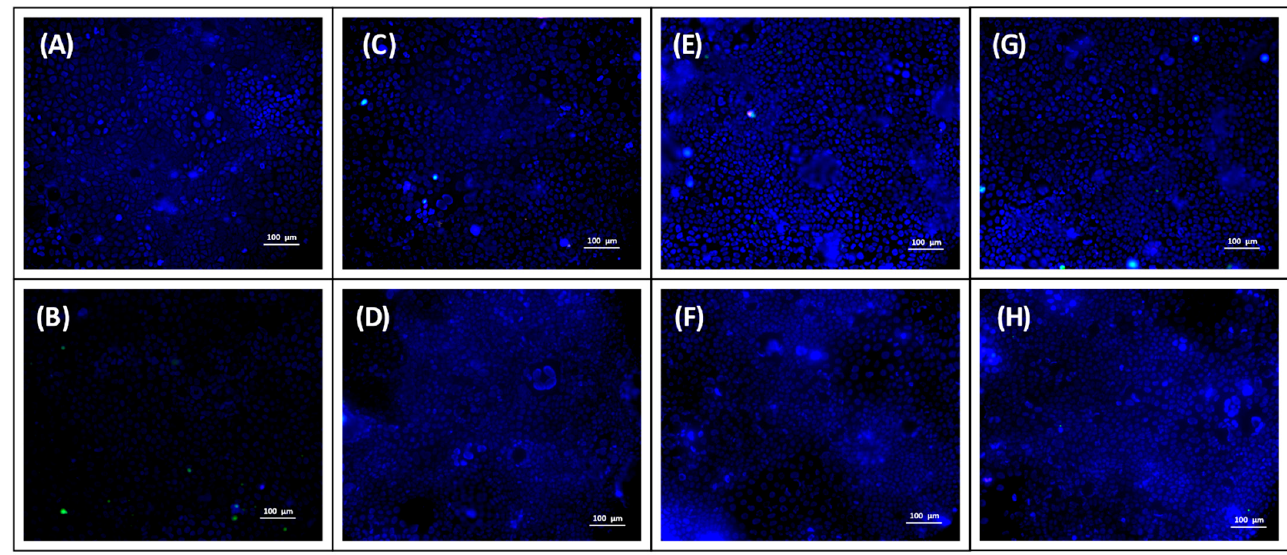
Figure 10. Fluorescence microscope images of fluorescently labeled oligonucleotide (OND) ( A ) MES-HBSS buffer, ( B ) OND solution in MES-HBSS buffer, ( C , D ) nonloaded Citrem and Standard SEDDS dispersed in OND solution, respectively, ( E , F ) DDAB-OND loaded in Citrem and Standard SEDDS, respectively, and ( G , H ) DOTAP-OND loaded in Citrem and Standard SEDDS, respectively. The size bar represents 100 µm. Blue represents the cell nuclei of living cells stained by Hoechst dye, red represents dead cells stained by propidium iodide and green represents fluorescently labeled OND.